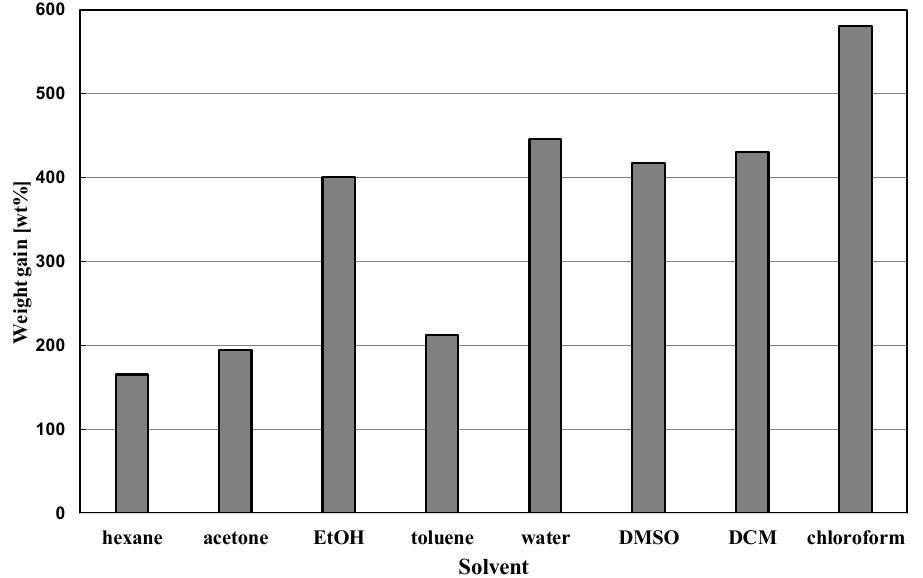
Figure 5. Absorbance capacity of AM4-HDA porous polymer I-10w-25d, feed molar ratio of AM4/HDA: 1/2, monomer concentration in reaction solution: 10 wt %, preparation temperature 25 °C.